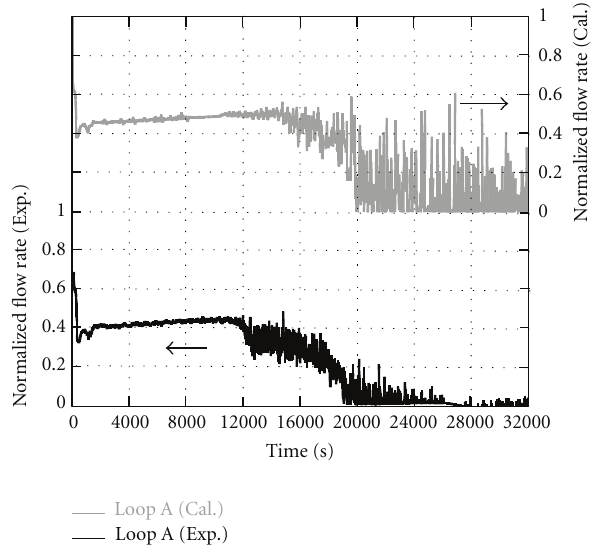
Figure 9: LSTF and RELAP5 results for primary mass flow rate in loop with PZR.